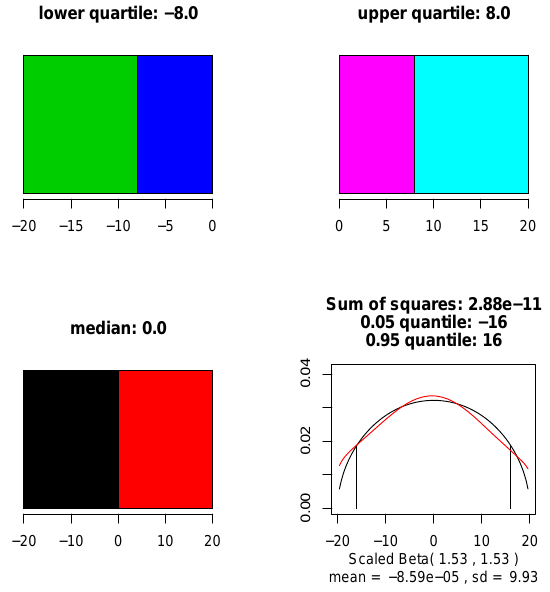
Figure 3. SHELF Feedback plot during group elicitation of the dis- tribution for scenario